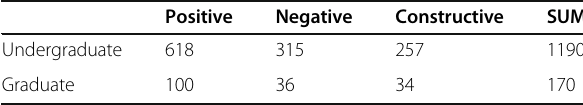
Table 5 Summed Total of Identified